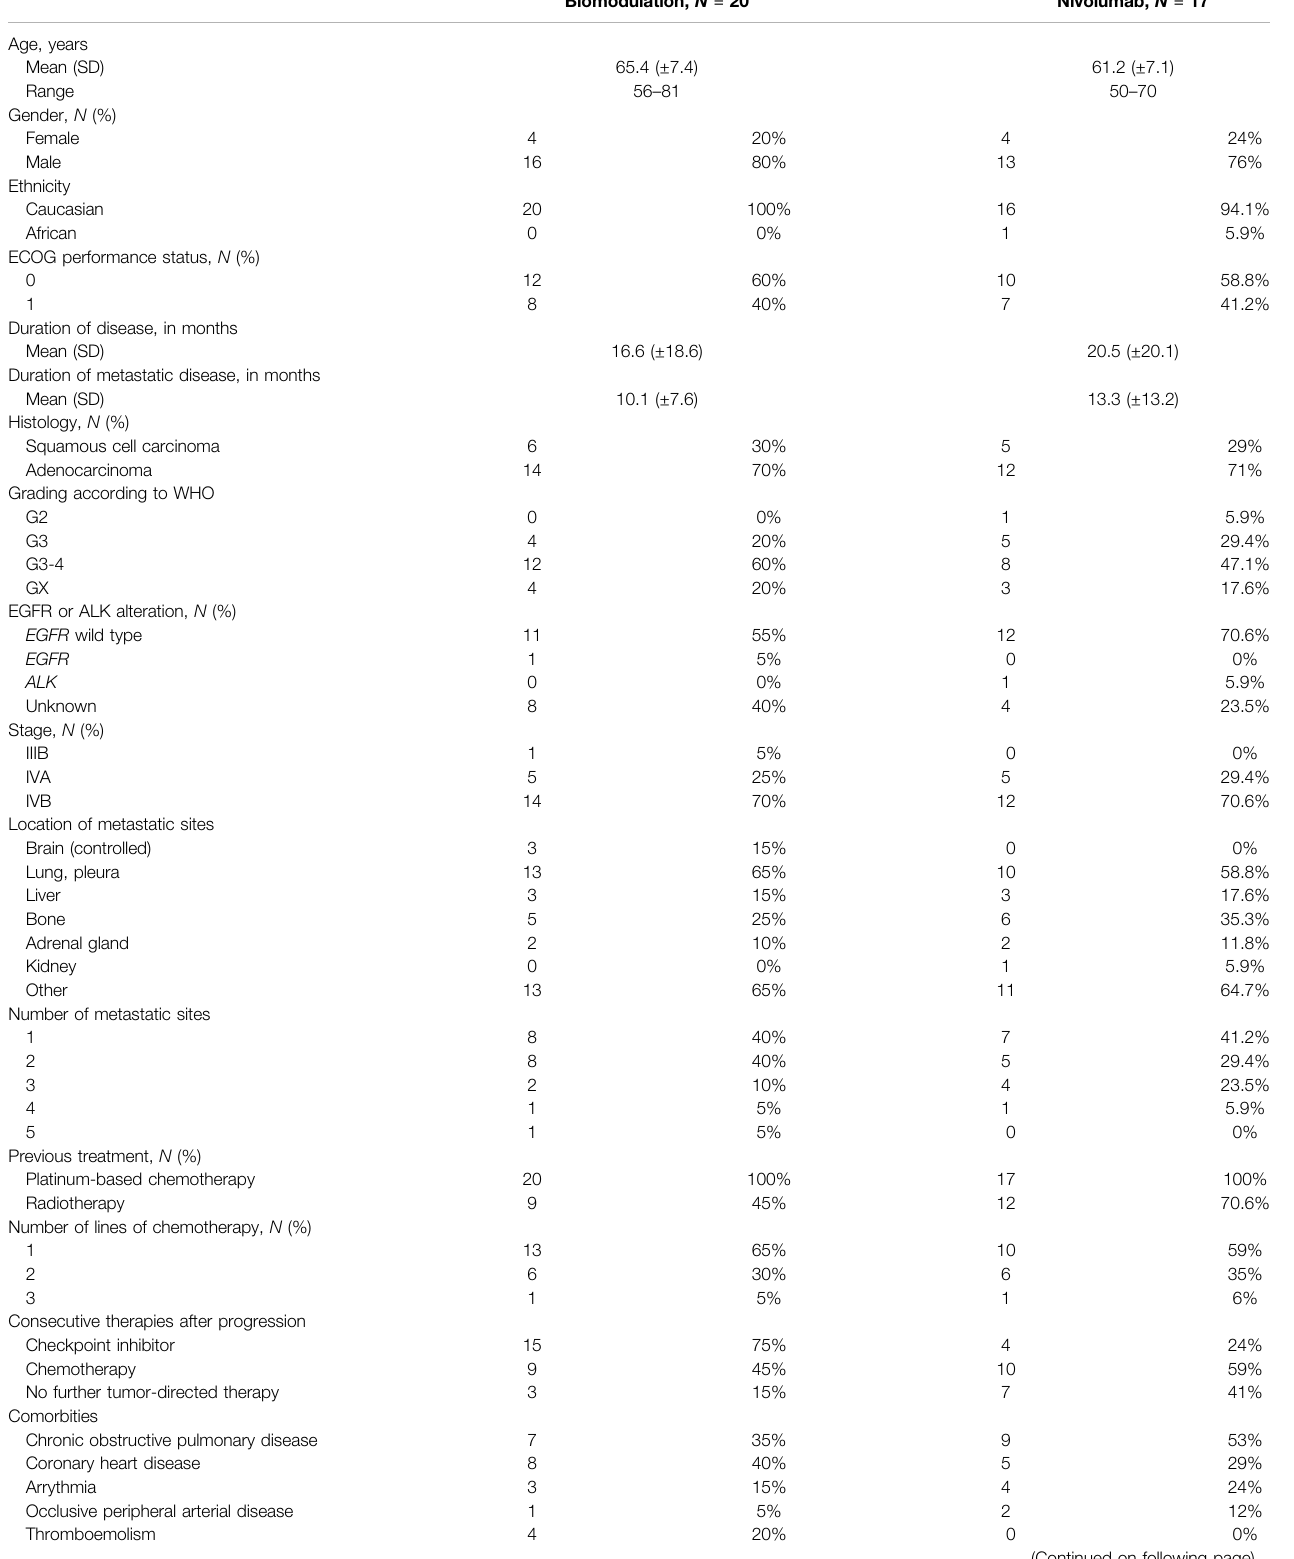
TABLE 1 | Baseline patients ’ characteristics ( N (cid:1)